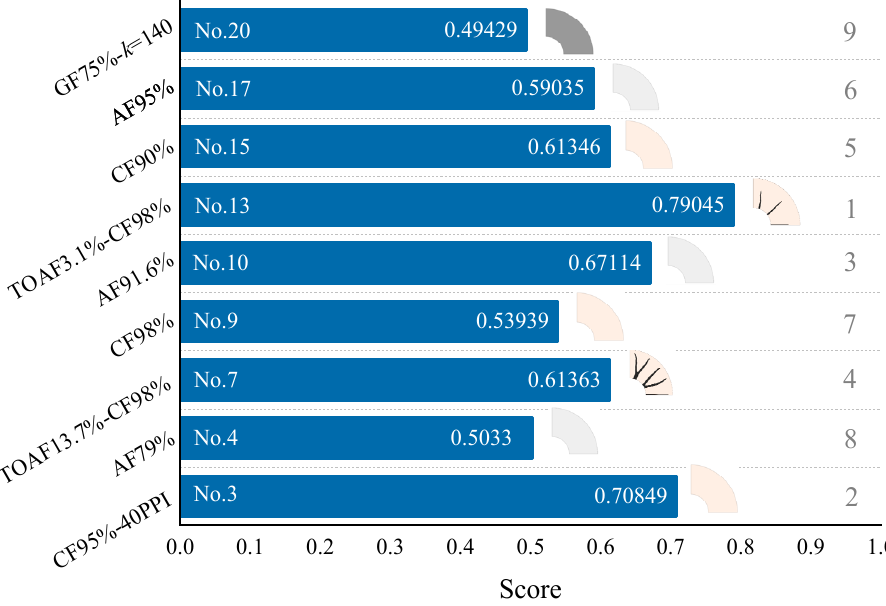
Figure 11. Ranking of 9 preferred alternatives.